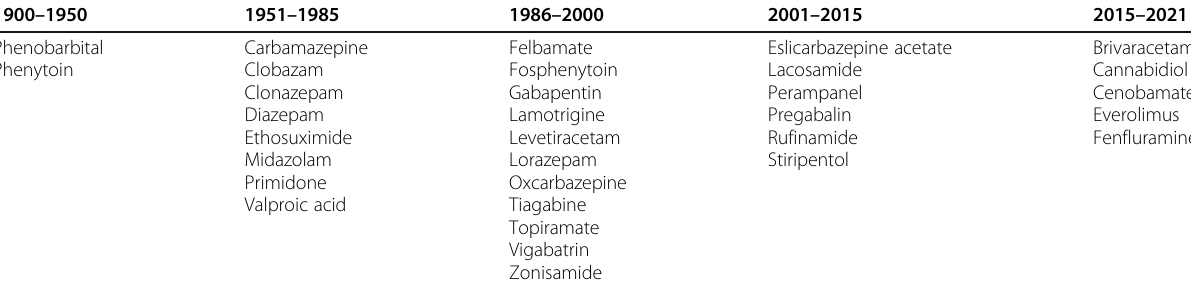
Table 1 Years of introduction in the market of currently available antiseizure medications. For all drugs, year of introduction refers to either Europe or the United States of America. The table does not include a number of drugs approved before 1970, but rarely used